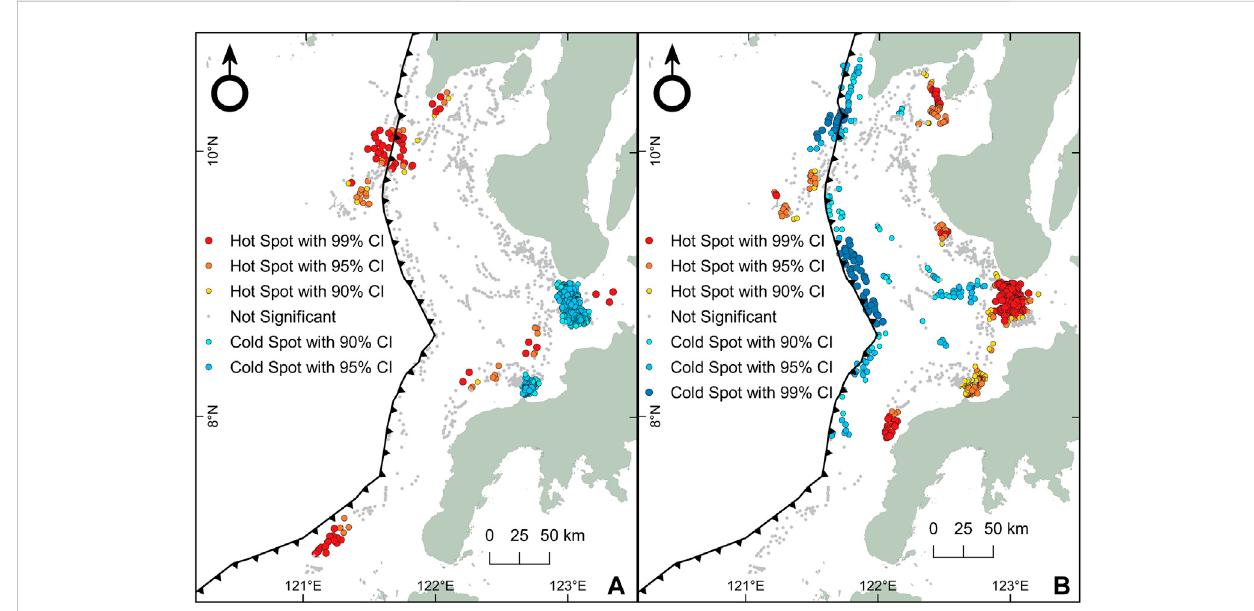
FIGURE 12 Getis-Ord (Gi*) analysis of submarine landslide distribution with respect to volume and L/W. (A) Signi fi cant clusters of large-volume submarine landslides(reddots)arefoundindifferentregionsoftheactivemargin,butthedensestclustersareinthenorthernNTsegment(NT1),wherecollisionwith the Cagayan Ridge occurs. Signi fi cant clusters of small-volume submarine landslides (blue dots) are located offshore of Negros Island and Zamboanga Peninsula, corresponding to areas with the densest submarine canyon systems (Figure 11A). (B) Signi fi cant clusters of high L/W (red dots) are also in regions with dense submarine canyon systems. On the other hand, the frontal wedge and abyssal plain host signi fi cant clusters of low L/W (blue dots).